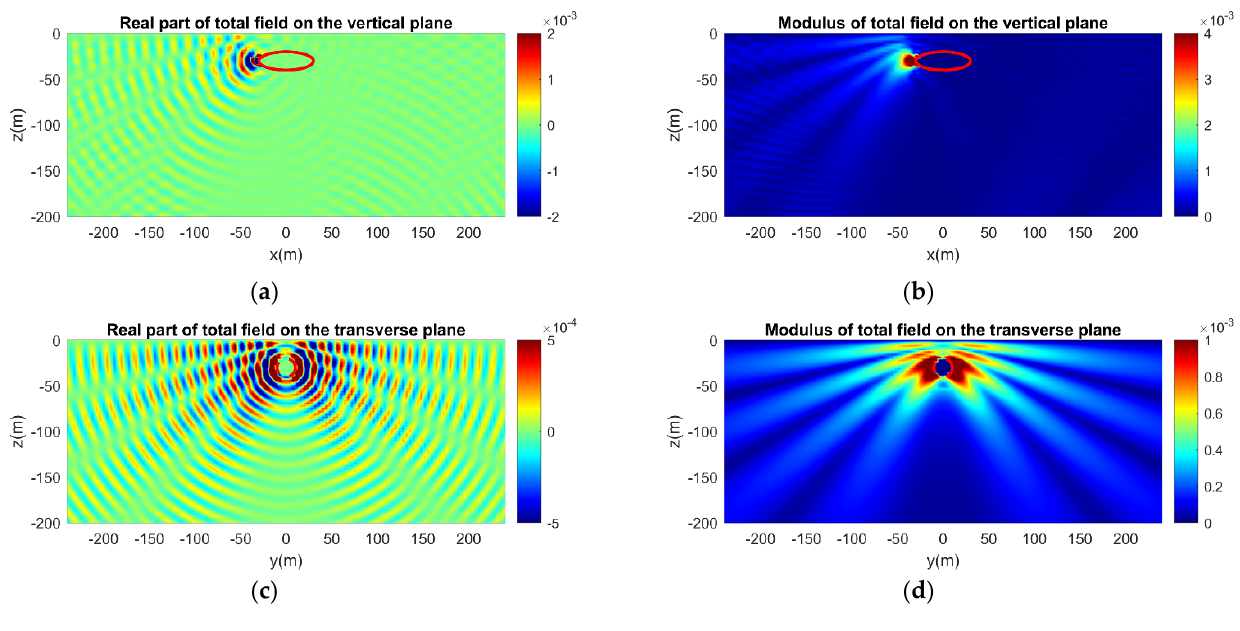
Figure 15. Same as Figure 14, but for a horizontal dipole source. The axis of the dipole is parallel to